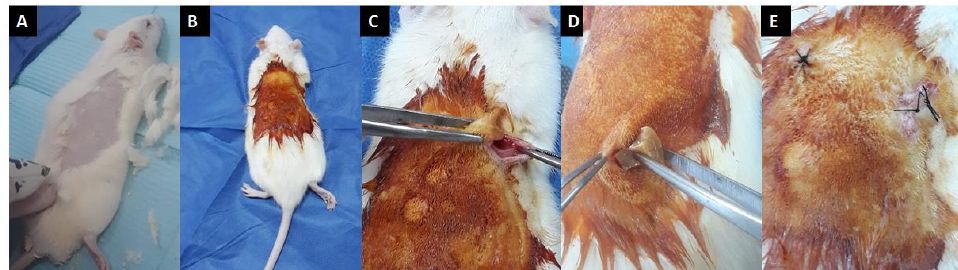
Figure 2. Surgical procedure. ( A ) — shaved rat dorsum, ( B ) — betadine painting of the rat dorsum, ( C ) — a subcutaneous pocket for hydrogel implantation, ( D ) — site of hydrogel implantation, ( E ) — suturing.